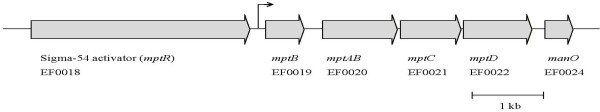
Genetic organization of the mannose PTS operon of E. faecalis V583 and the preceding σ54-associated activator gene mptR. The mpt operon contains the mpt genes, an additional gene encoding an EIIB and the distal gene that resembles manO. The σ54-promoter sequence is indicated by an arrow.